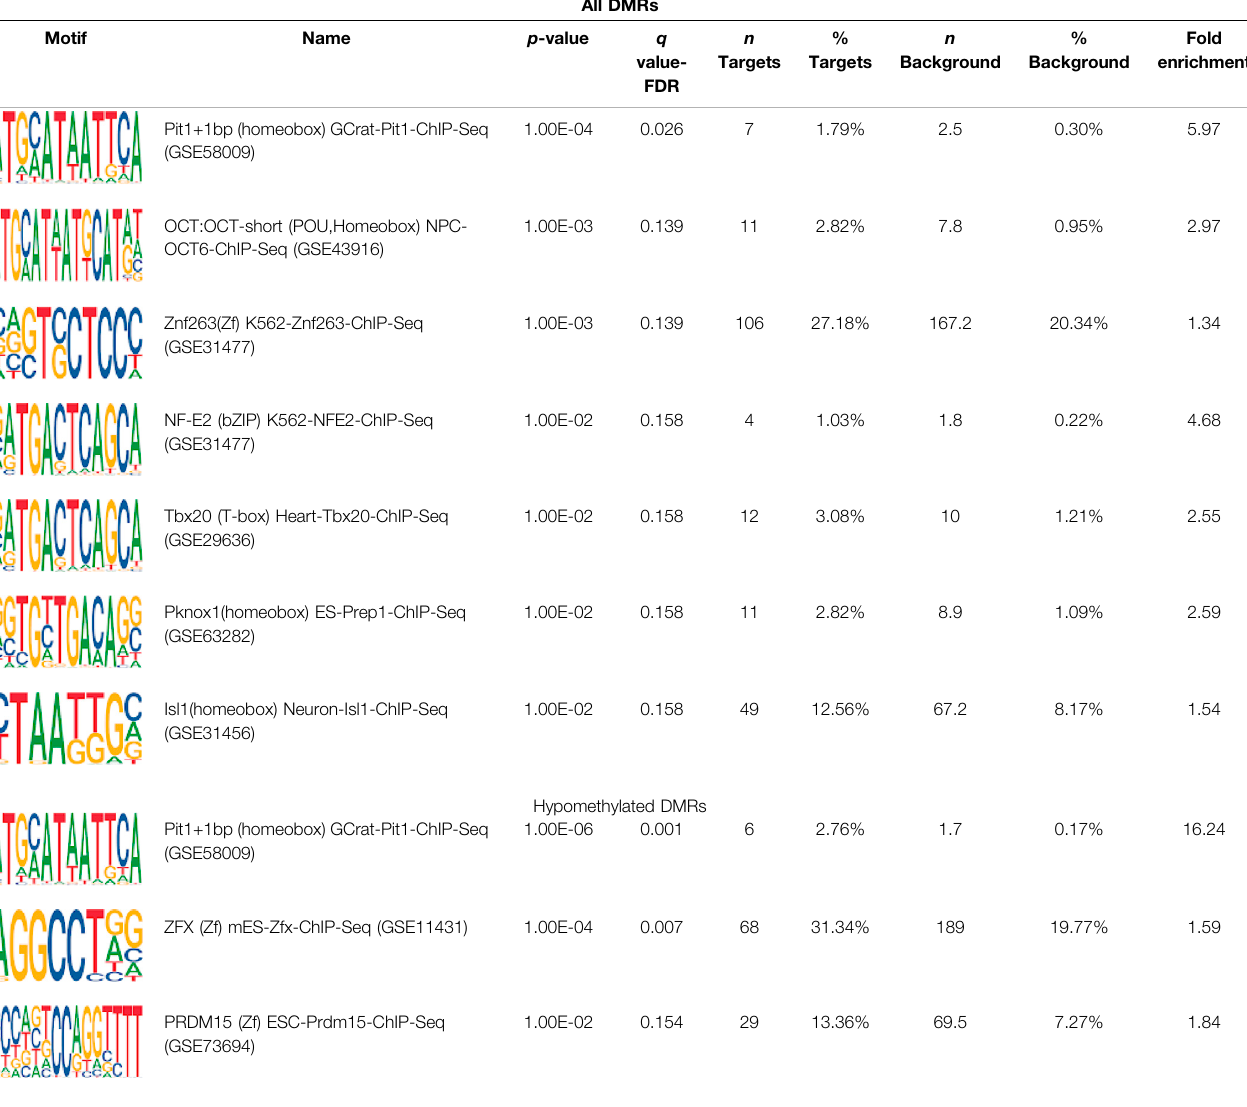
TABLE3| HOMERTFBSmotifenrichmentresultsforallDMRsandhypomethylatedDMRsforTSv.46,XXindicatingsigni fi cantenrichmentfor PIT1 and ZFX ( q value <